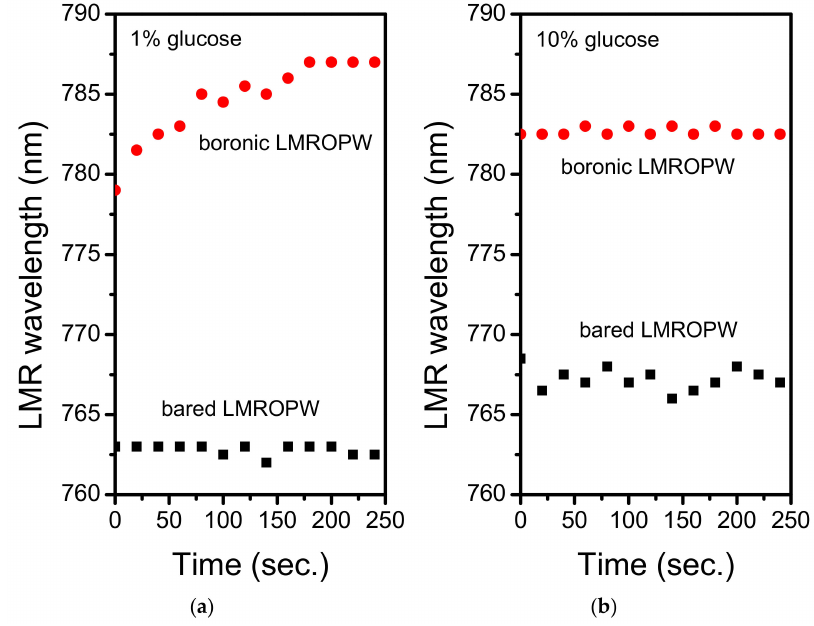
Figure 8. Time courses of the LMR wavelength variation for ( a ) 1% glucose solution and ( b ) 10% glucose solution dropped on the bared LMROPW sensor and on the boronic LMROPW